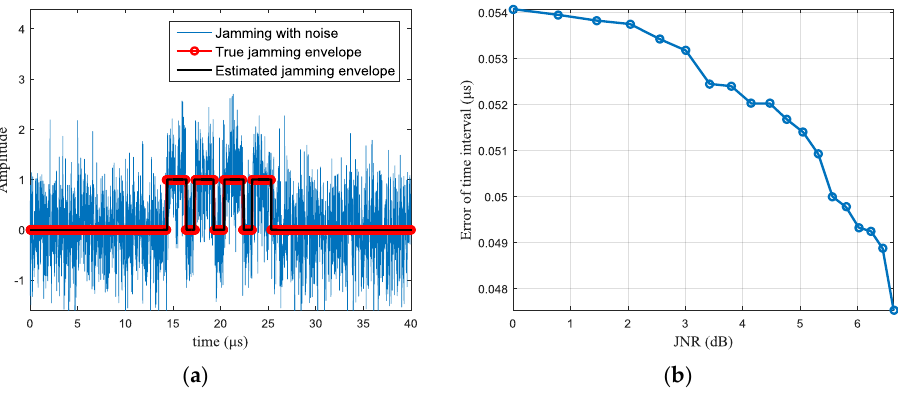
Figure 5. Simulations of jamming perception ( a ) estimation results of jamming parameters with jamming-to-noise ratio (JNR) =0 dB ( b ) jamming parameters estimation errors VS. JNR.